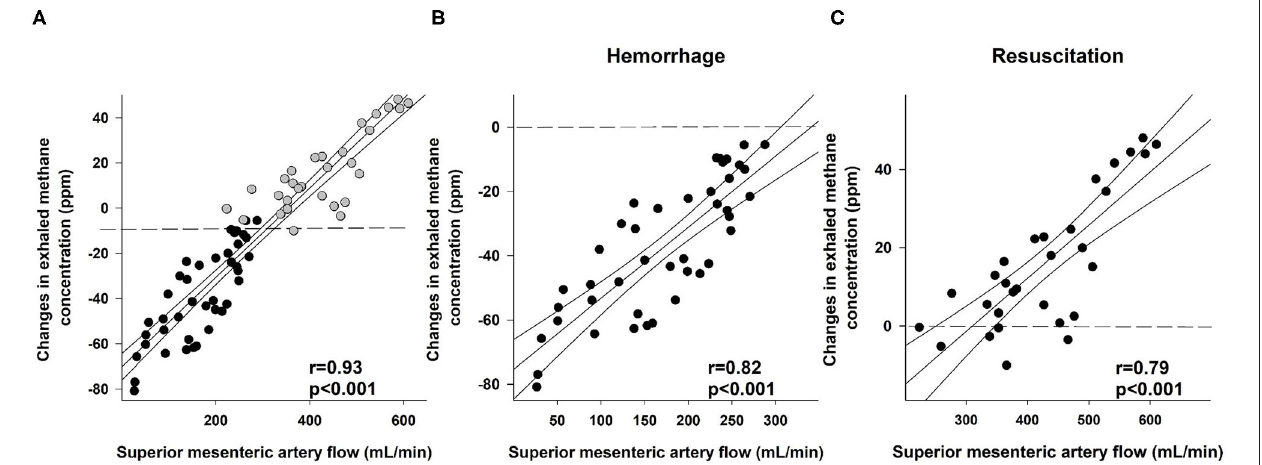
FIGURE 4 | Correlation between superior mesenteric artery flow (ml min − 1 ) and changes in exhaled methane concentration (ppm) during the whole course of experiments ( A ; black scatters show the data collected during bleeding, and gray scatters show the data recorded during resuscitation), the hemorrhage ( B ; black scatters) and resuscitation phases ( C ; black scatters). The plot demonstrates the regression line (black line) and corresponding r values as indicators of the strength of the linear correlation and p significance values.